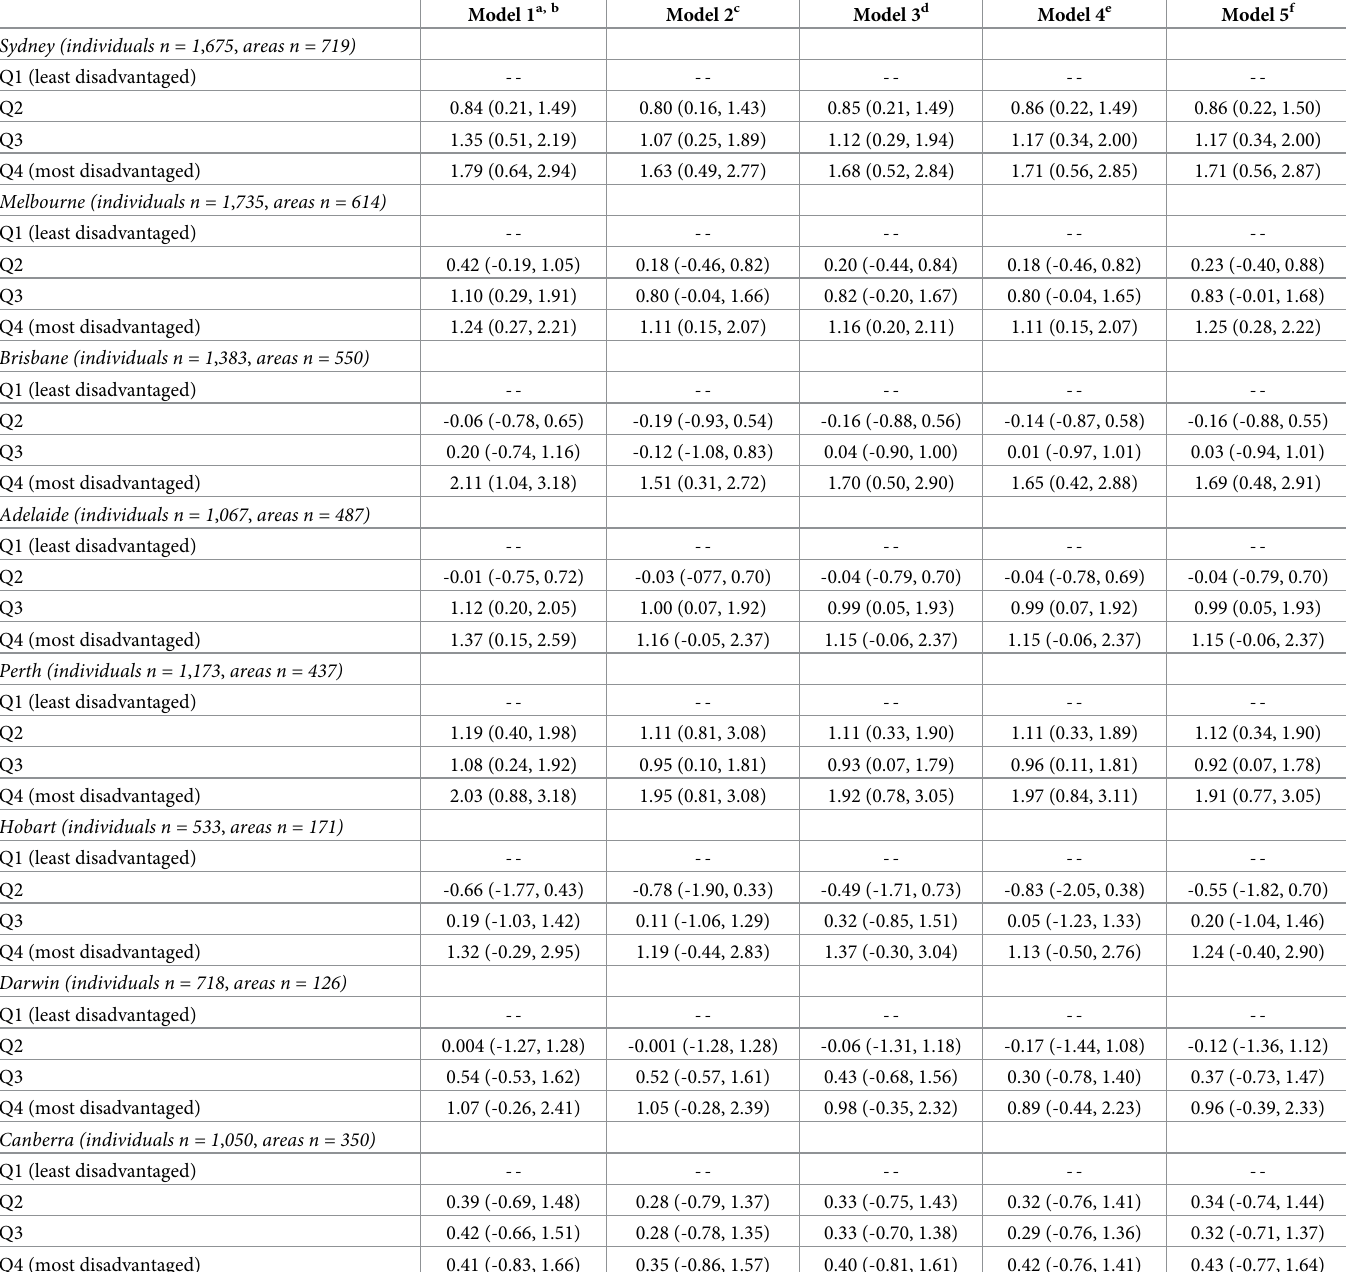
Table 4. Neighbourhood disadvantage and body mass index (kg/m 2 ), before and after adjustment for residential distance to the CBD, and count of supermarkets and walkable amenities, by capital city (multilevel linear